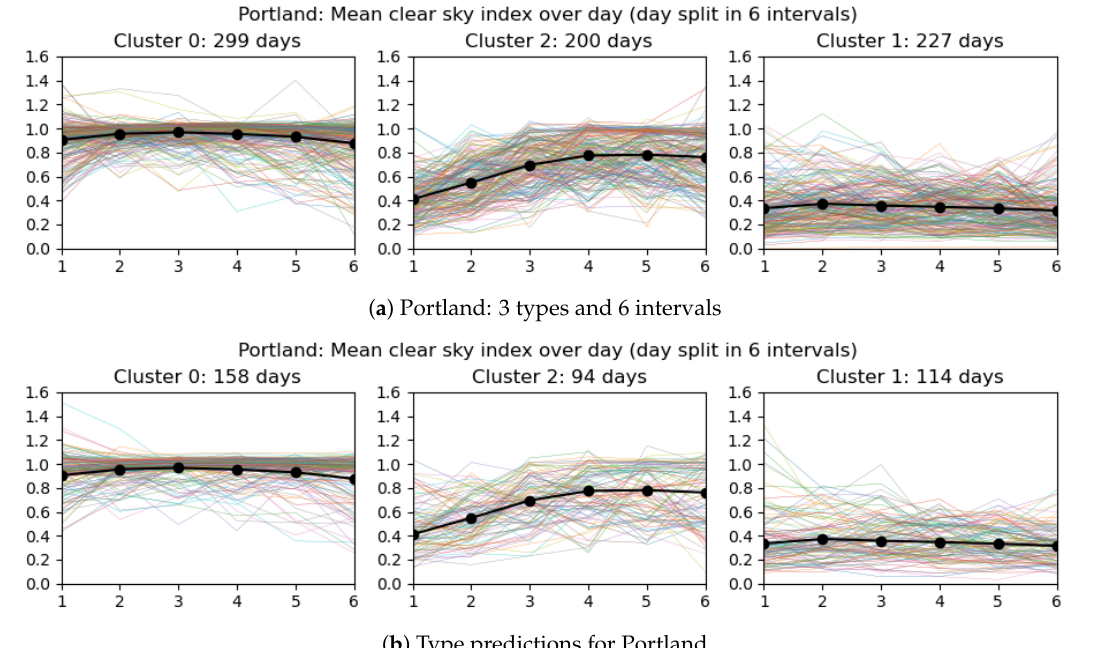
Figure 7. Days’ characteristics and their types for Portland: training data on top, testing data on bottom.